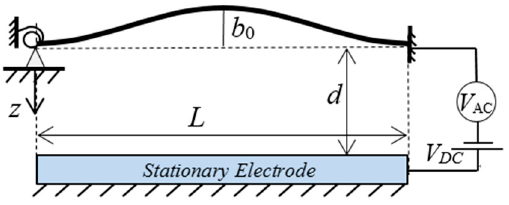
Figure 1. Schematic of an electrically actuated shallow arch with flexible boundary.